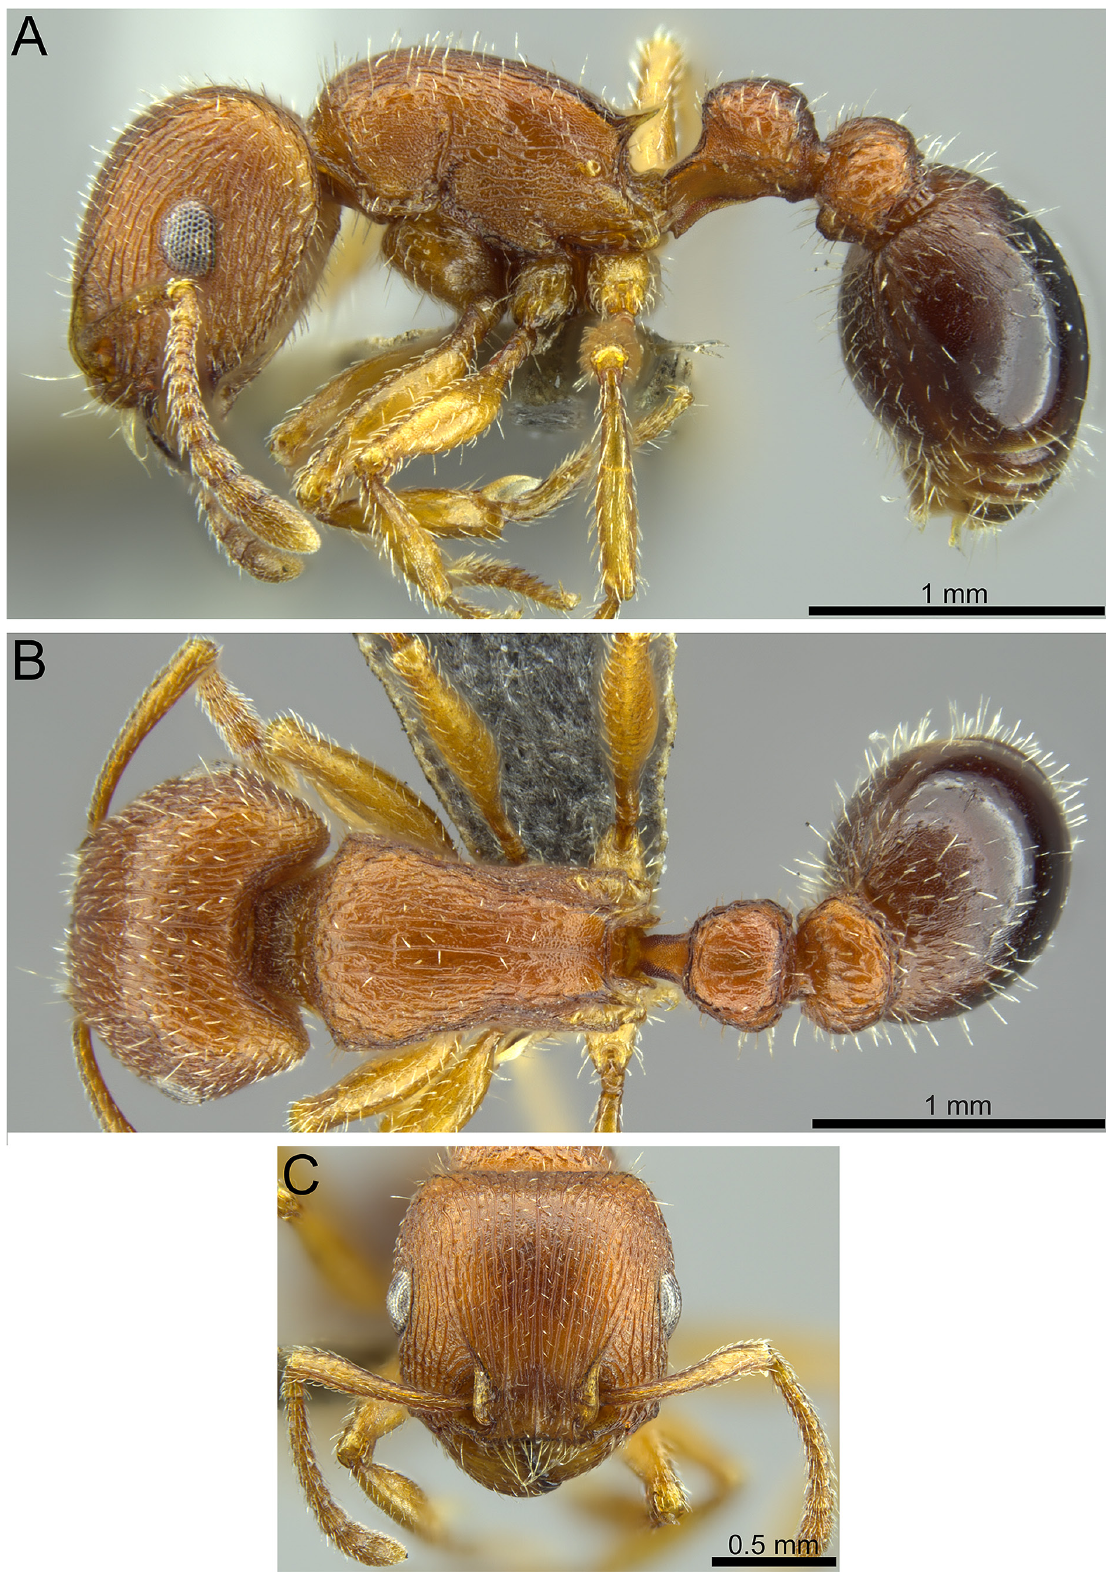
Fig. 9. Tetramorium dichroum Santschi, 1932 (CASENT0746320). A . Body in profile. B . Body in dorsal view. C . Head in full-face